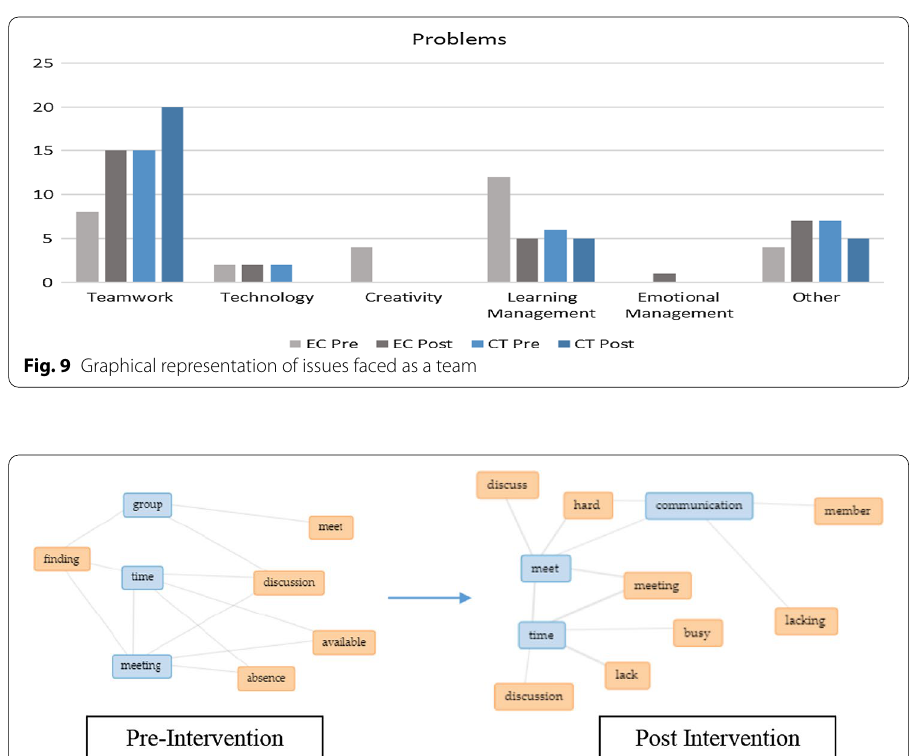
Fig. 10 Change in perception for the EC group based on issues faced as a team